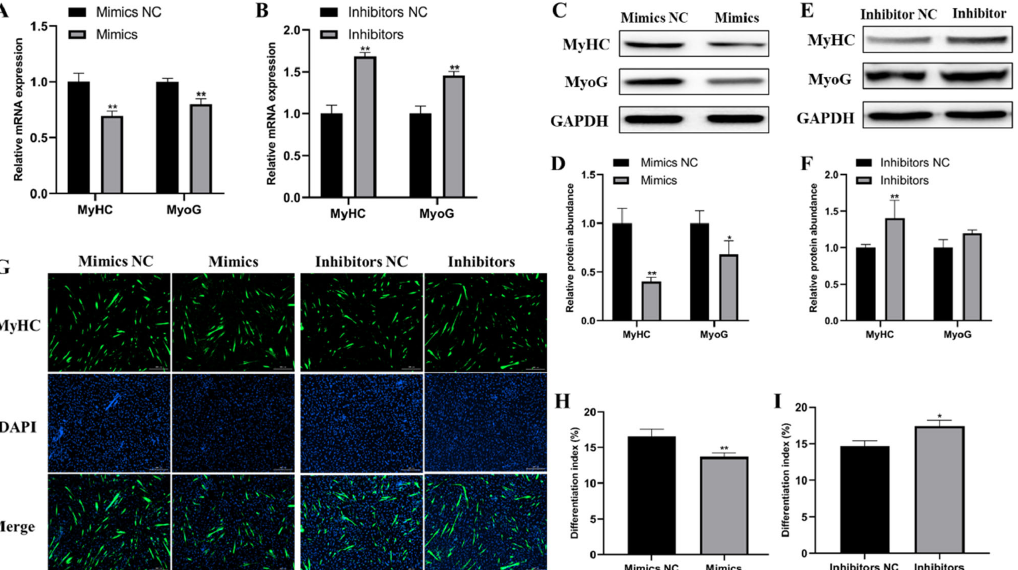
Figure 3. miR ‐ 487b ‐ 3p inhibits goat myoblast differentiation. ( A , B ) Myosin heavy chain ( MyHC ) and myogenin ( MyoG ) mRNA expression detected by qRT ‐ PCR in differentiated cells transfected with miR ‐ 487b ‐ 3p mimics, miR ‐ 487b ‐ 3p inhib ‐ itors, or NC. ( C , D ) Western blot detected protein expression of MyHC and MyoG after miR ‐ 487b ‐ 3p overexpression. ( E , F ) Western blot detected protein expression of MyHC and MyoG after miR ‐ 487b ‐ 3p knockdown. ( G – I ) Differentiation index counted by MyHC ‐ positive cells to total nuclei. Data are shown by mean ± SEM of three independent experiments. * p < 0.05; ** p < 0.01.